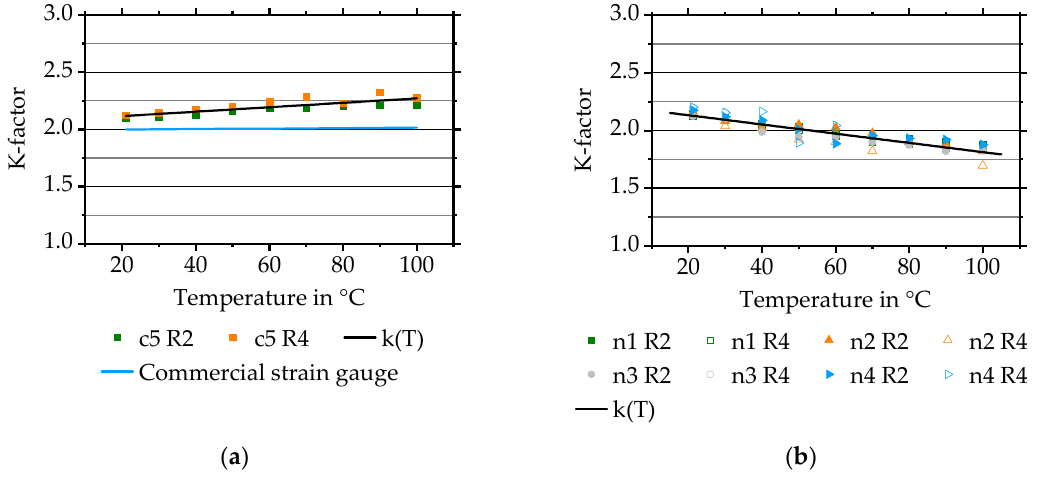
Figure 7. ( a ) K-factor temperature behaviour of Constantan quarter-bridges, manufactured on one sample, compared to a commercial strain gauge. ( b ) K-factor temperature behaviour of NiCr 80/20. Achieved values for directly deposited strain gauges with stoichiometry of CuNiMn 54/45/1 correspond to literature values at room temperature but show an approximately 8% higher temperature dependency with a value of 2.25 at 100 °C compared to just 2.09 for commercial ones.